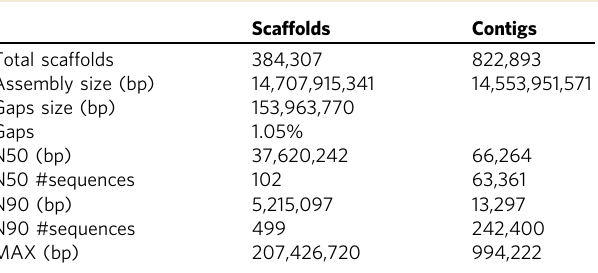
Table 1 Summary statistics for the Zang1817